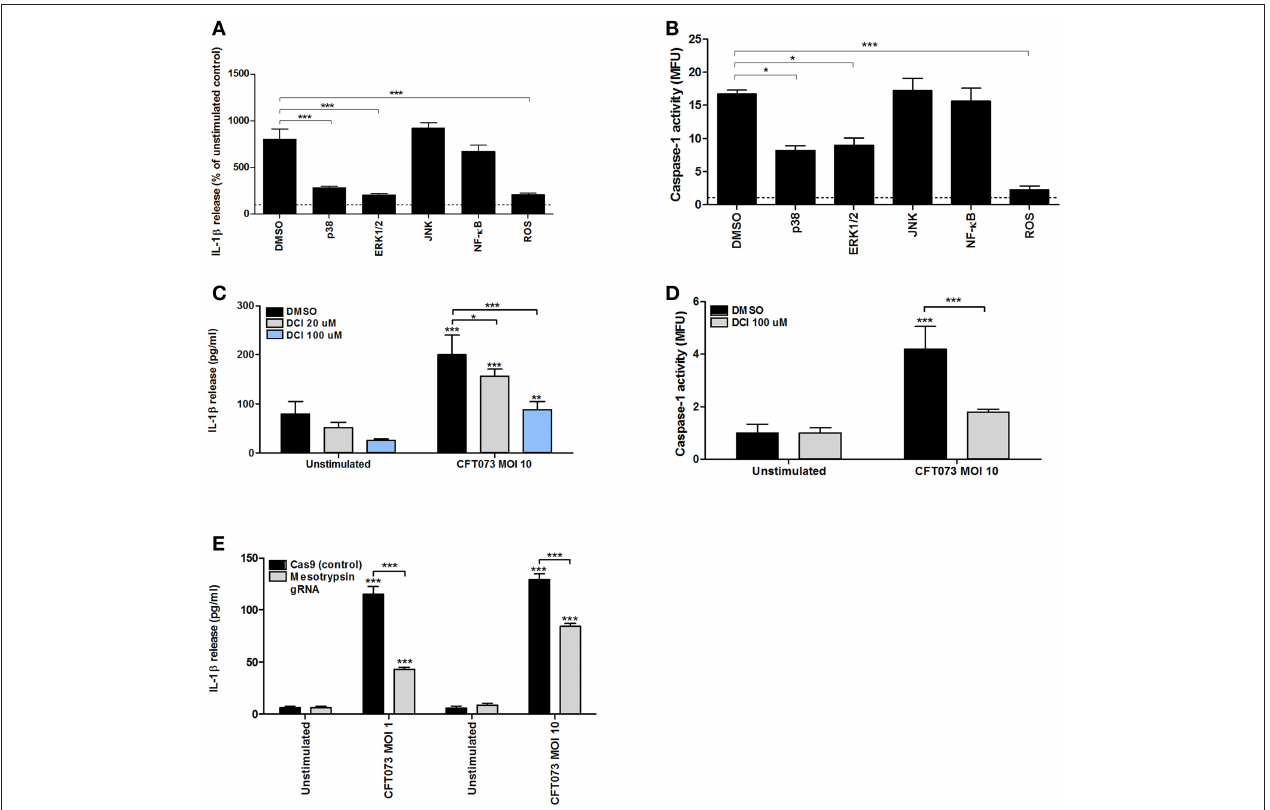
FIGURE 7 | Signaling pathways associated with CFT073-induced IL-1 β release and caspase-1 activity. Bladder epithelial 5637 cells were pre-incubated with DMSO (vehicle), JNK inhibitor SP600125 (10 µ M), p38 MAPK inhibitor SB203580 (10 µ M), ERK1/2 inhibitor PD98059 (10 µ M), NF- κ B inhibitor BAY 11-7082 (5 µ M), reactive oxygen species (ROS) inhibitor diphenyleneiodonium chloride (DPI, 10 µ M) (A,B) , serine protease inhibitor 3,4-dichloroisocoumarin (DCI) (C,D) for 1h prior to infection with CFT073 at MOI 1 and MOI 10 for 6h followed by analysis of IL-1 β release (A,C) and caspase-1 activity (B,D) . Caspase-1 activity is presented as fold increase of mean fluorescence units (MFU) compared to unstimulated control cells (dotted line). IL-1 β release is presented as % of unstimulated control and the dotted line represents the unstimulated control (A) . Cas9 (control cells) or mesotrypsin deficient 5,637 cells were infected with CFT073 for 6h at MOI 1 and MOI 10 and IL-1 β release was measured (E) . Data are presented as mean ± SEM ( n = 3 independent experiments). Asterisks denote statistical significance compared to respective unstimulated control (* p < 0.05, ** p < 0.01, *** p <